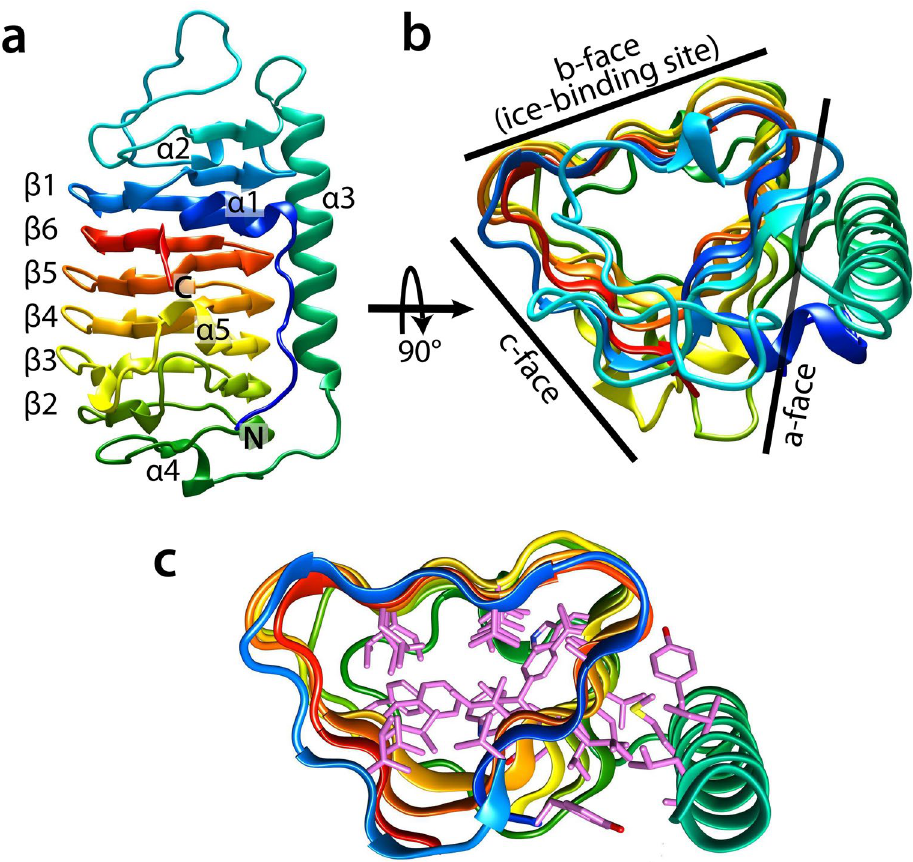
Figure 3. Schematic illustration of the Tis AFP7 crystal structure. ( a ) View along the normal to the β-helical axis with the N- and C-termini denoted in blue and red, respectively (the helical axis runs in parallel to the page, from top to bottom, and the molecule is viewed along the axis perpendicular to the helical axis). Helical coils of irregular length are denoted as β-1, and β-6 to β-2, from N-terminal half of the solenoid. The long α-helix is denoted as α-3, with additional 3 10 helices numbered α-1, α-2, α-4, and α-5. ( b ) View along the β-helical axis upon 90° rotation of the view in ( a ), showing a triangular cross-section (the helical axis is perpendicular to the page). The molecular faces of β-helix are denoted as the a-, b-, and c-faces, accordingly. Here, the c-face is a putative ice-binding site. ( c ) Hydrophobic core formed within the β-helices, and between the a-face and α-3 helix, drawn as a stick model. The Tis AFP7 structures presented in this and other figures were prepared using UCSF Chimera 66